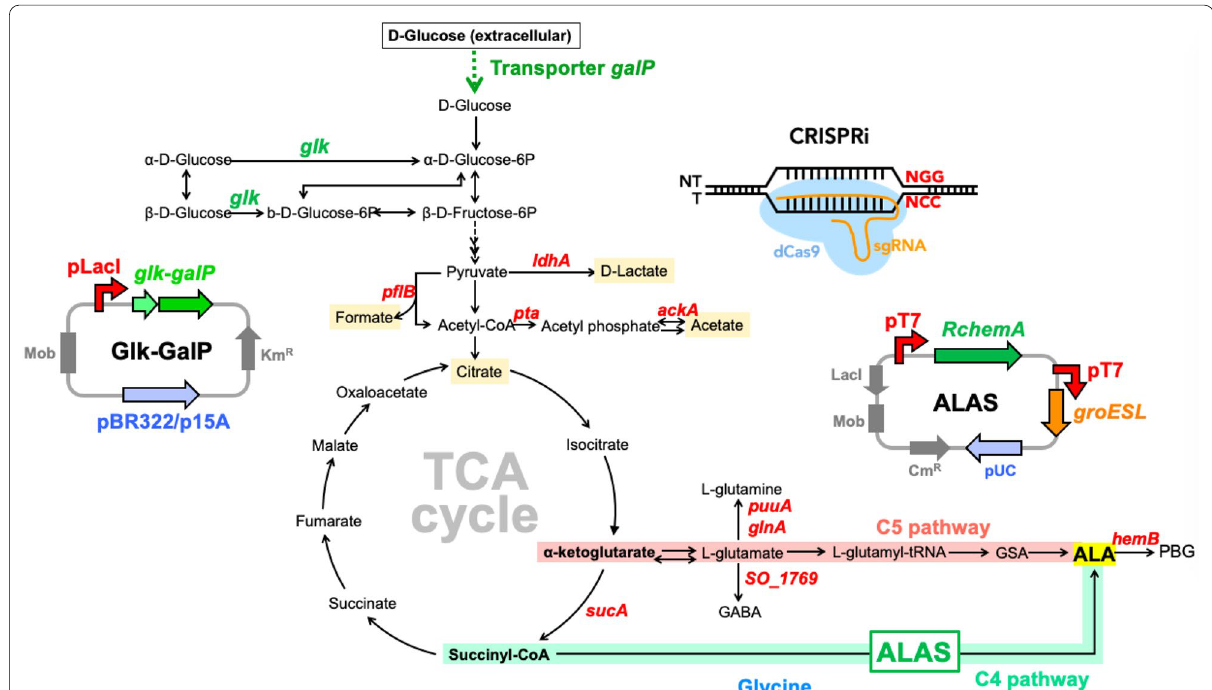
Fig. 1 Metabolic pathway and schematic diagram of 5‑ALA synthesis from glucose to TCA cycle. Genes shown in red were downregulated using the CRISPRi system, while metabolites represented in yellow were analyzed by HPLC. Two important plasmids for expression of RchemA with GroESL and Glk‑GalP were harboring in the genetic MR‑1